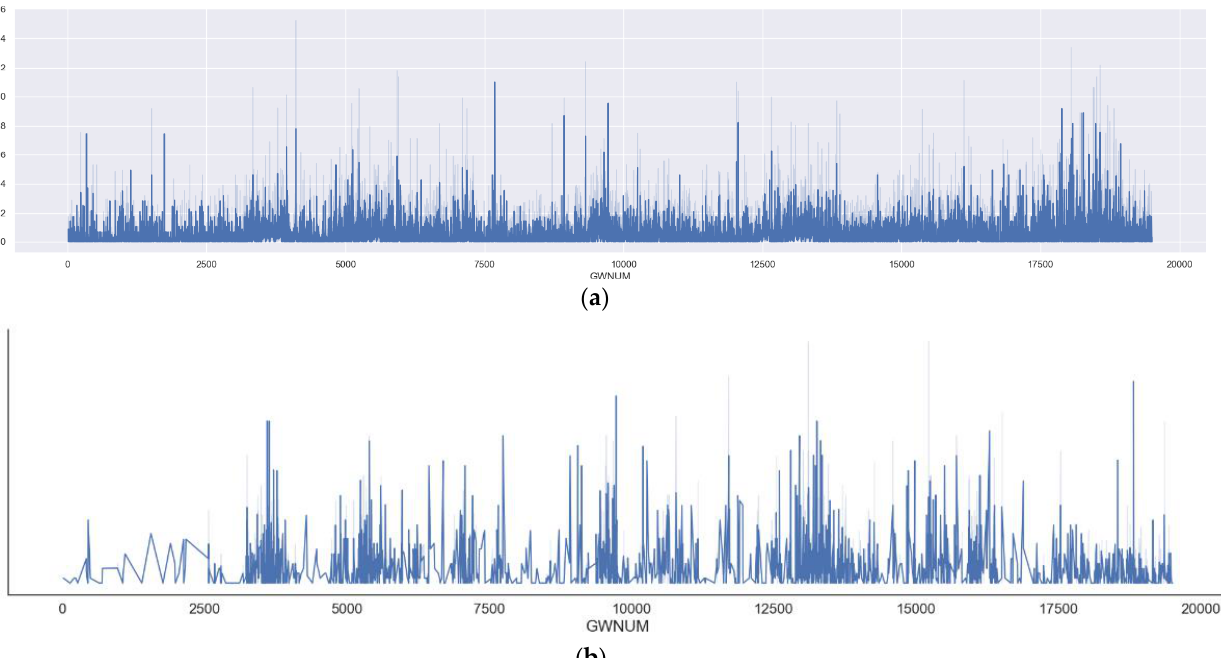
Figure 8 indicates the distribution of CGRs by the pipeline GWNUM.